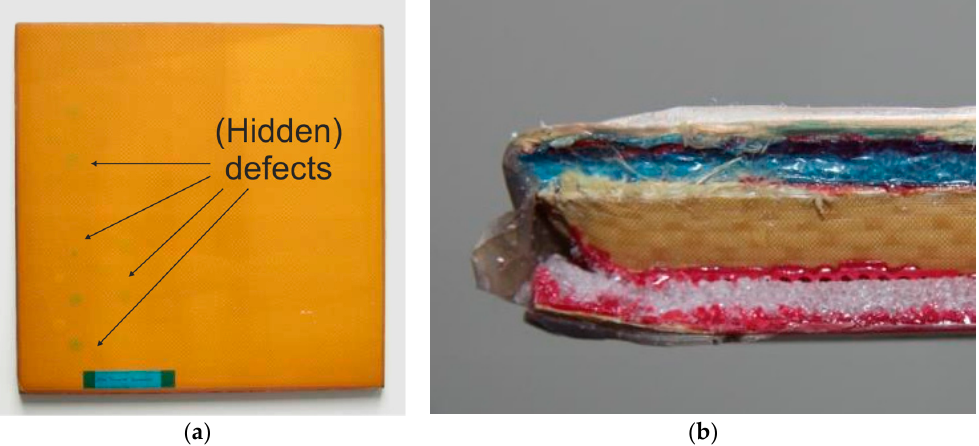
Figure 1. Two photographs of a glass fiber reinforced plastics (GFRP) test sample containing defined integrated defects and features. ( a ) Top view. Along the left edge of the sample, some of the defects can be recognized shining through the surface layer. ( b ) Side view. The sample consists of several layers of different materials (e.g., aramid and foams).